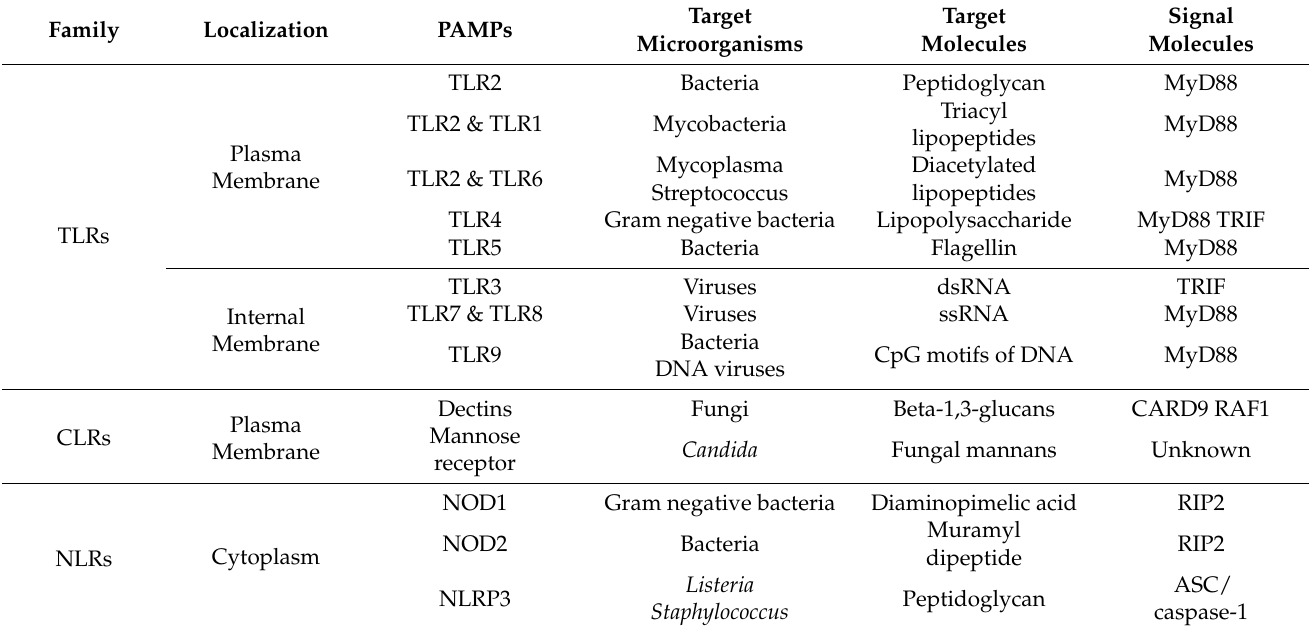
Table 1. Representative pattern recognition receptors in the intestine and their